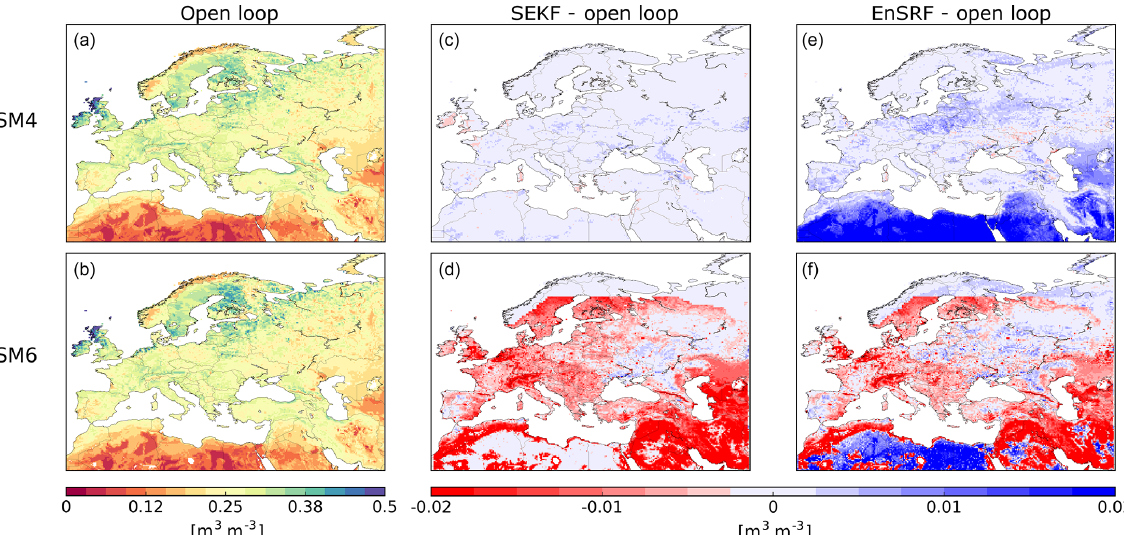
Figure 10. From left to right: averaged soil moisture for the open loop (fourth layer: 10–20cm; SM4; sixth layer: 40–60cm; SM6) over 2008–2017, averaged analysis impact for SEKF (c, d) and EnSRF (e, f) .